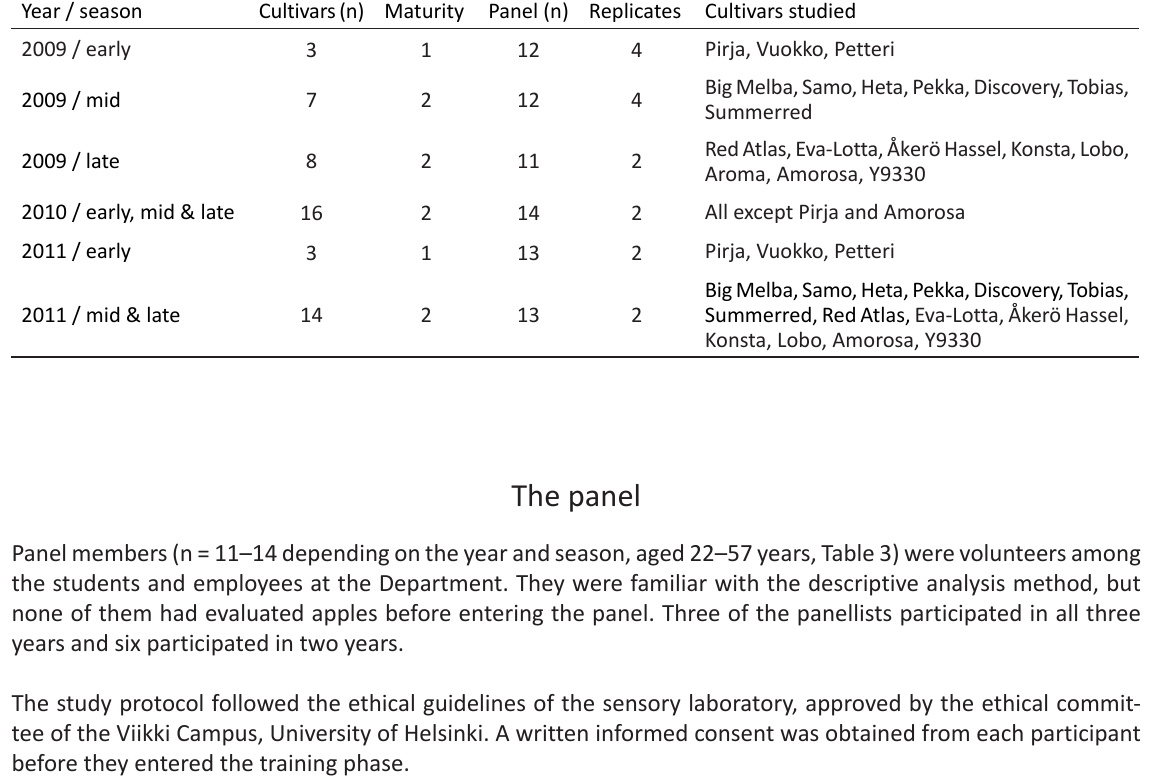
Table 3. Data collection settings for the cultivars with the number of storage points (maturity), size of the panel (n), and replicates Year /